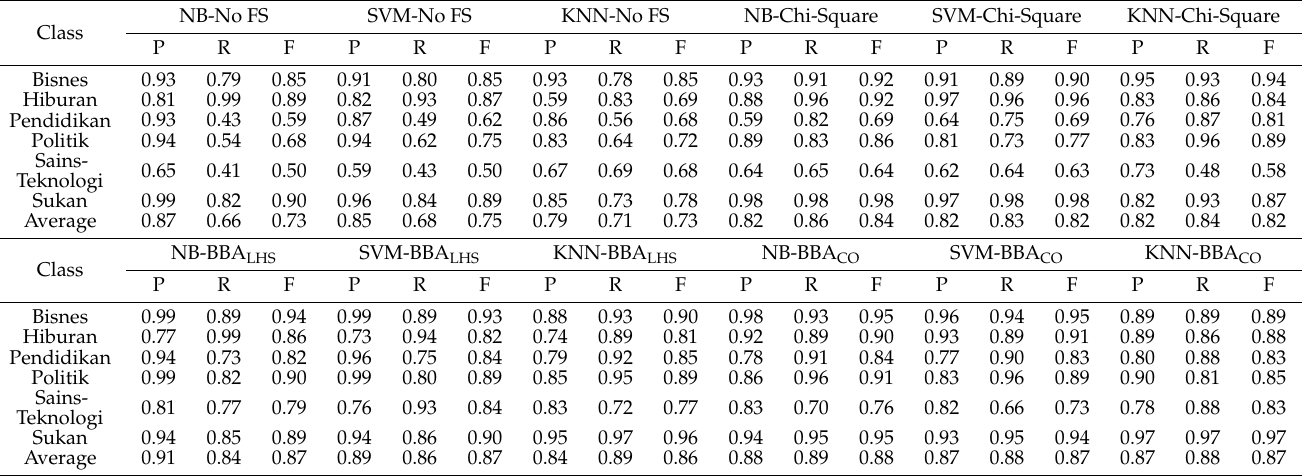
Table 19. Classification results of Mix-DS using NB, SVM and KNN classifiers in terms of precision (P), recall (R) and F-measure (F).